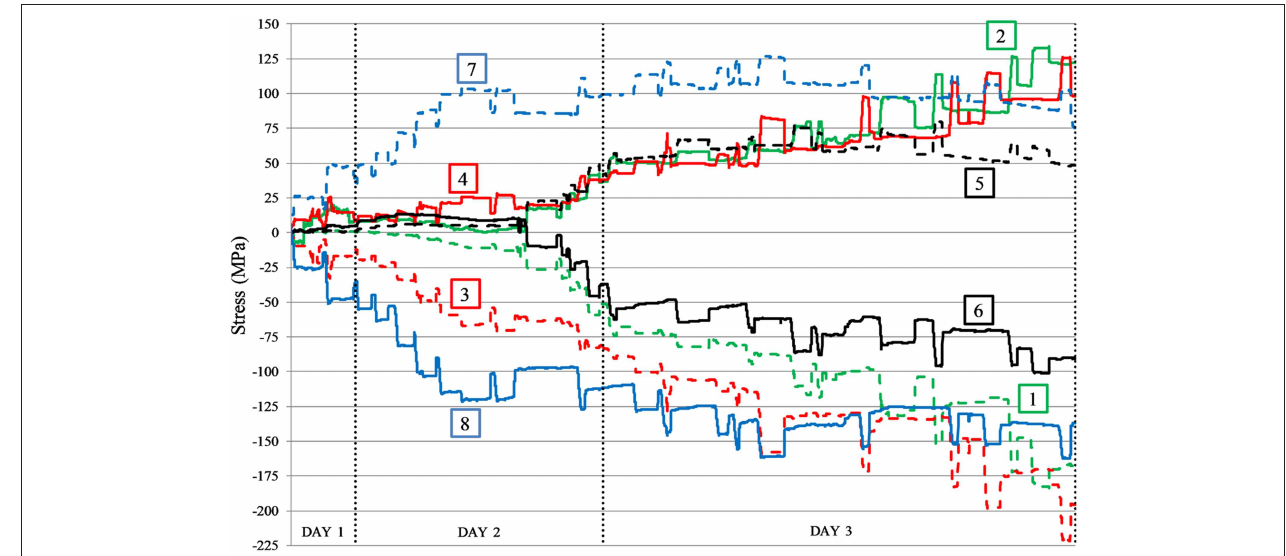
FIGURE 5 | Calculated stresses at all measuring points